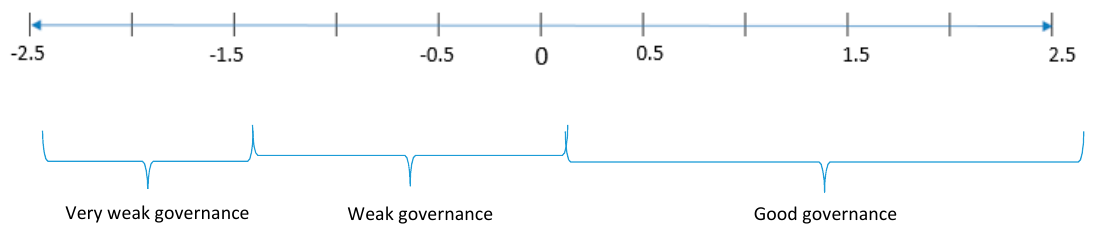
Figure 2. Scale for governance variables; Source: Own elaboration.